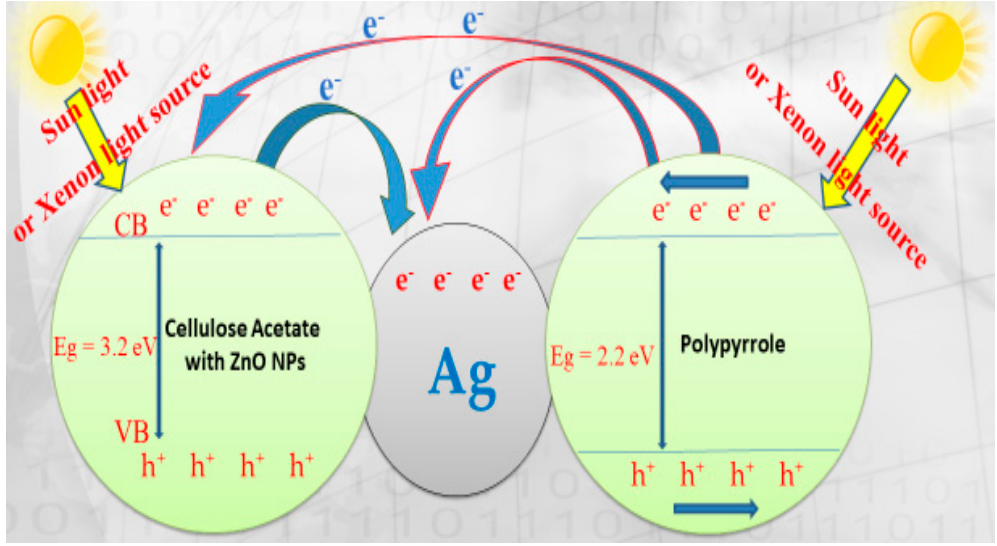
Figure 12. OH + Malachite green dye → products (CO 2 and H 2 O). Scheme diagram of the photocatalytic degradation mechanism of malachite green dye (MG) on ZnO polymeric nanofiber immobilized with silver.